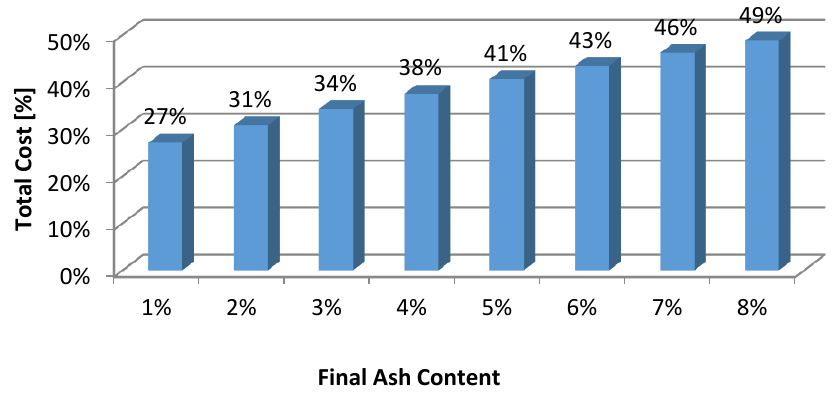
Figure 7. Percentage of quality-related costs with respect to total cost (for a moisture content of 50%).